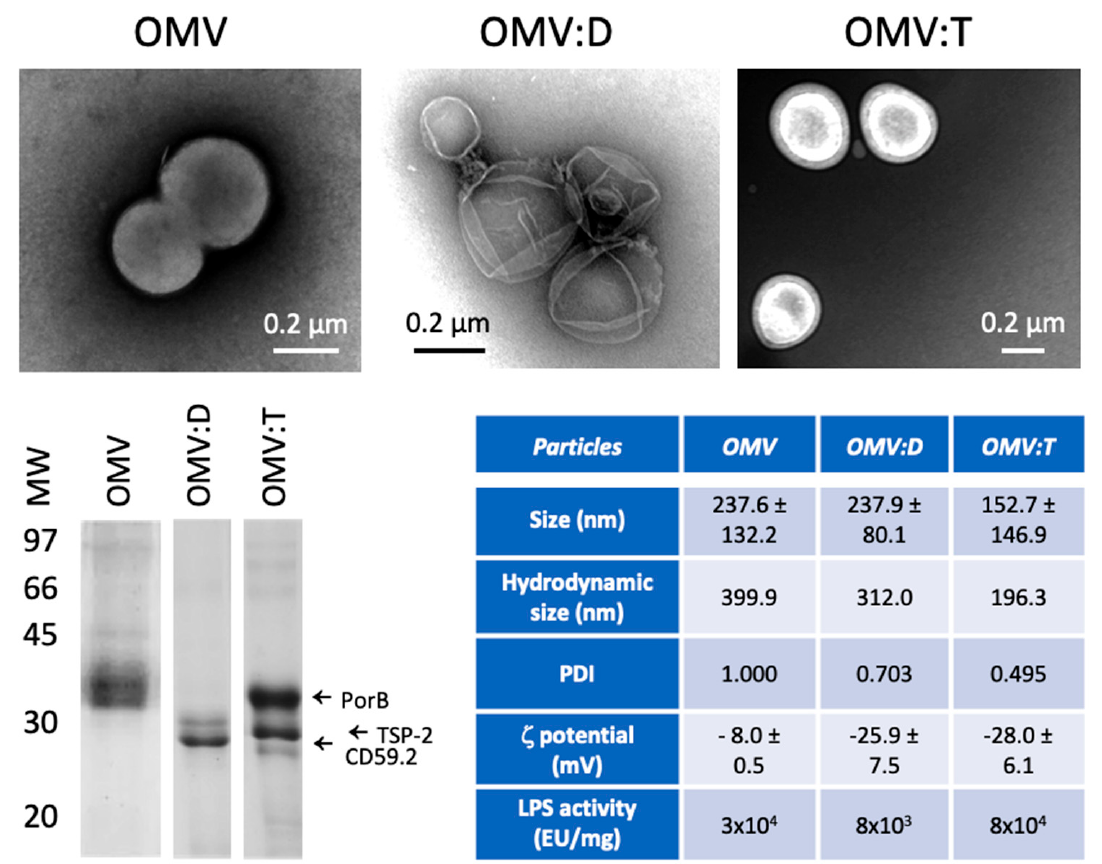
Figure 1. Characterization of Outer Membrane Vesicles (OMV) and OMV–antigen complexes. TEM images of uncon- jugated biotinylated OMV of N. lactamica (OMV, upper left), OMV conjugated with rRzvSmCD59.2 (OMV:D, upper center) and OMV conjugated with rRzvSmTSP-2 (OMV:T, upper right). Lower left panel: electrophoretic mobility of OMV and OMV–antigen complexes. Left arrows indicate the position of the main N. lactamica protein PorB, of SmTSP-2 in OMV:T and of SmCD59.2 in OMV:D (the two antigens having a calculated MW of 27.2 kDa for rRzvSmTSP-2 and 26.9 kDa for rRzvSmCD59.2). Lower right table: Summary of the OMV characteristics of size (measured in TEM, mean ± SD of 16–131 particles), hydrodynamic size, polydispersity, ζ -potential (mean of 3 determinations ± SD) (all measured by dynamic light scattering (DLS)) and LPS activity (measured with the LAL assay). PDI, polydispersity index.